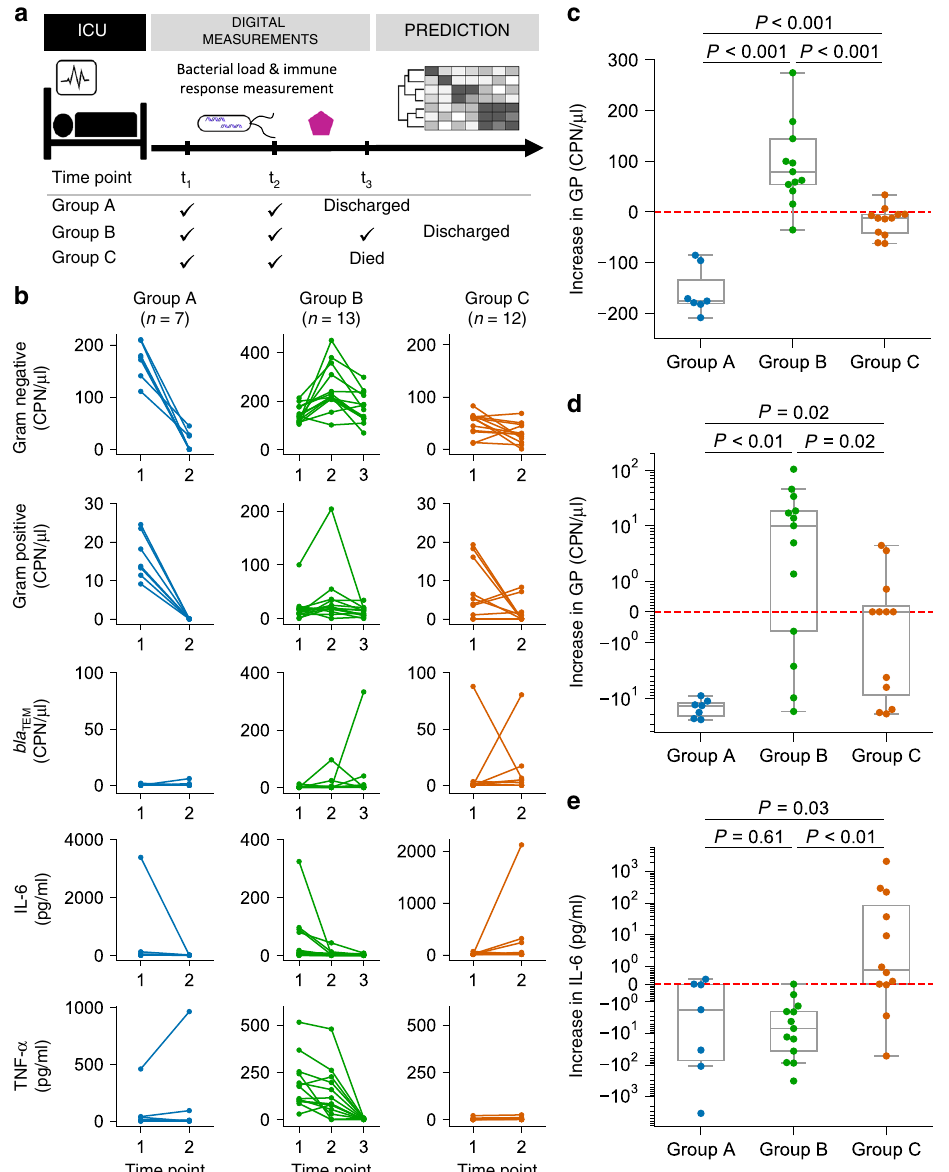
Fig. 4 Correlation between septic shock outcomes and changes in GN bacteria, IL-6 protein, and bla TEM . a Plasma was collected from patients with septic shock in the ICU, and measured by our digital PLA/digital PCR protocol at different time points to quantify cytokines and bacterial DNA. Patients were classi fi ed into three groups by their outcomes, i.e., early recovery (group A) ( n = 7), late recovery (group B) ( n = 13), and death (group C) ( n = 12). b Measurements of GN bacteria, GP bacteria, bla TEM , IL-6, and TNF- α in the three patient groups. c – e Temporal increase in ( c ) GN, ( d ) GP, and ( e ) IL-6 between time points t 1 and t 2 . In ( c – e ), each box shows the lower and upper quartile values, the line inside the box shows the median, and the whiskers extend to the value 1.5× the interquartile range beyond the box. The red horizontal dashed lines indicate no detectable changes between the two time points. Note the scale of the y axes in ( d , e ): the scale is linear between − 1 and 1, logarithmic otherwise, and is symmetric about 0. ( c – e ) Two-sided Mann – Whitney U test with Benjamini – Hochberg